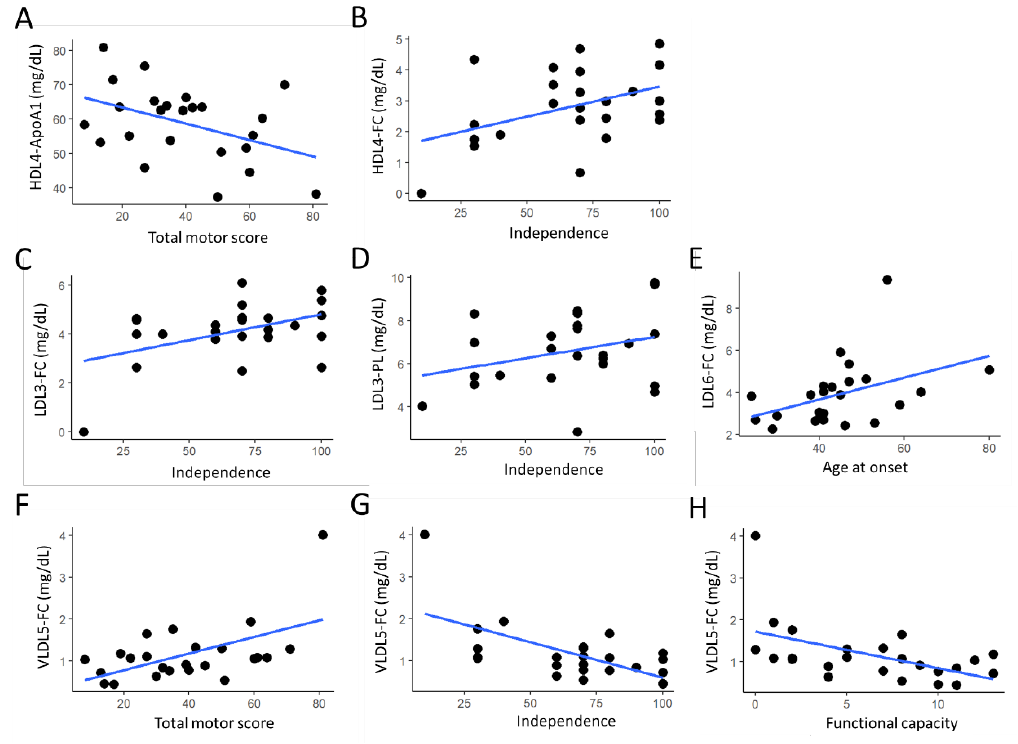
Figure 2. ( A – H ) The correlation between identified lipoprotein components and clinical parameters (Unified Huntington’s Disease Rating Scale including total motor score, independence score and functional capacity; age at onset) in symptomatic Huntington’s disease patients. Dots represent the data points for each patient. Blue lines denote the regression lines. ApoA1, apolipoprotein A1; FC, free cholesterol; HDL, high-density lipoprotein; LDL, low-density lipoprotein; PL, phospholipid; VLDL, very low-density lipoprotein.